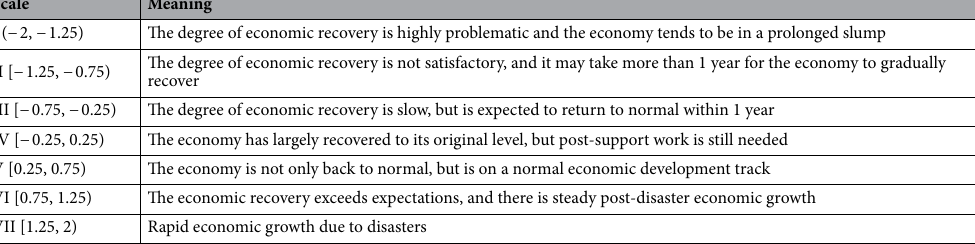
Table 2. Comprehensive recovery degree.